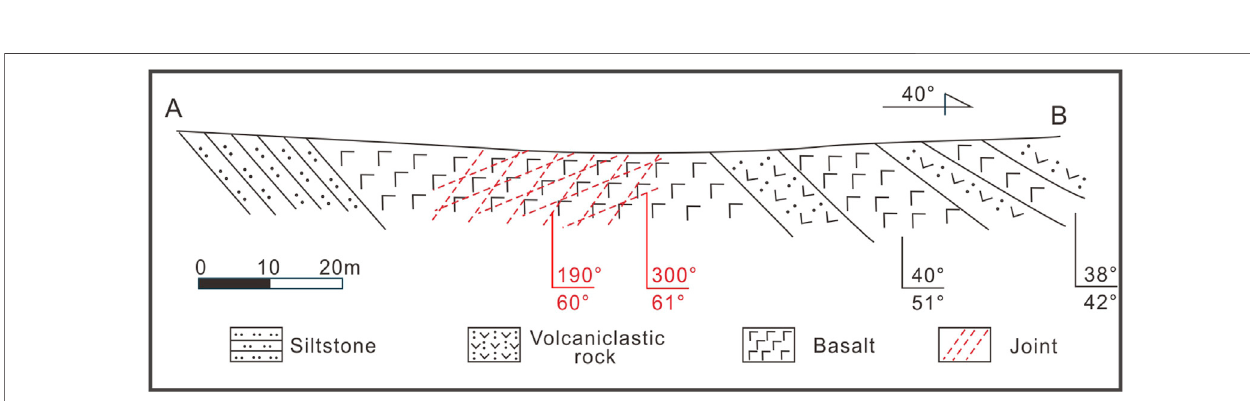
Frontiers in Earth Science |